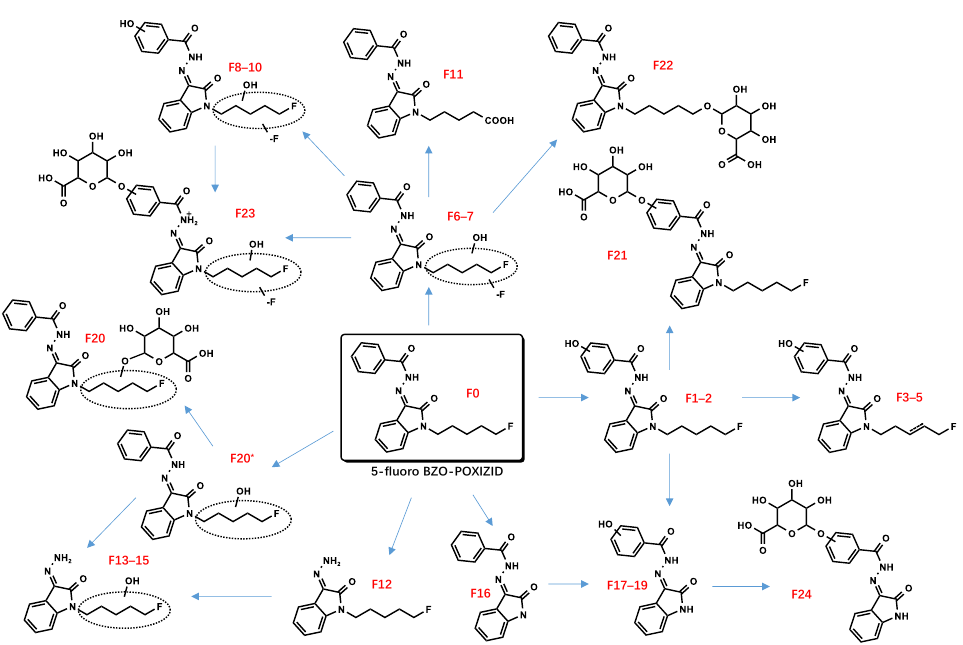
Figure 8. Proposed metabolic pathway of 5-fluoro BZO-POXIZID.